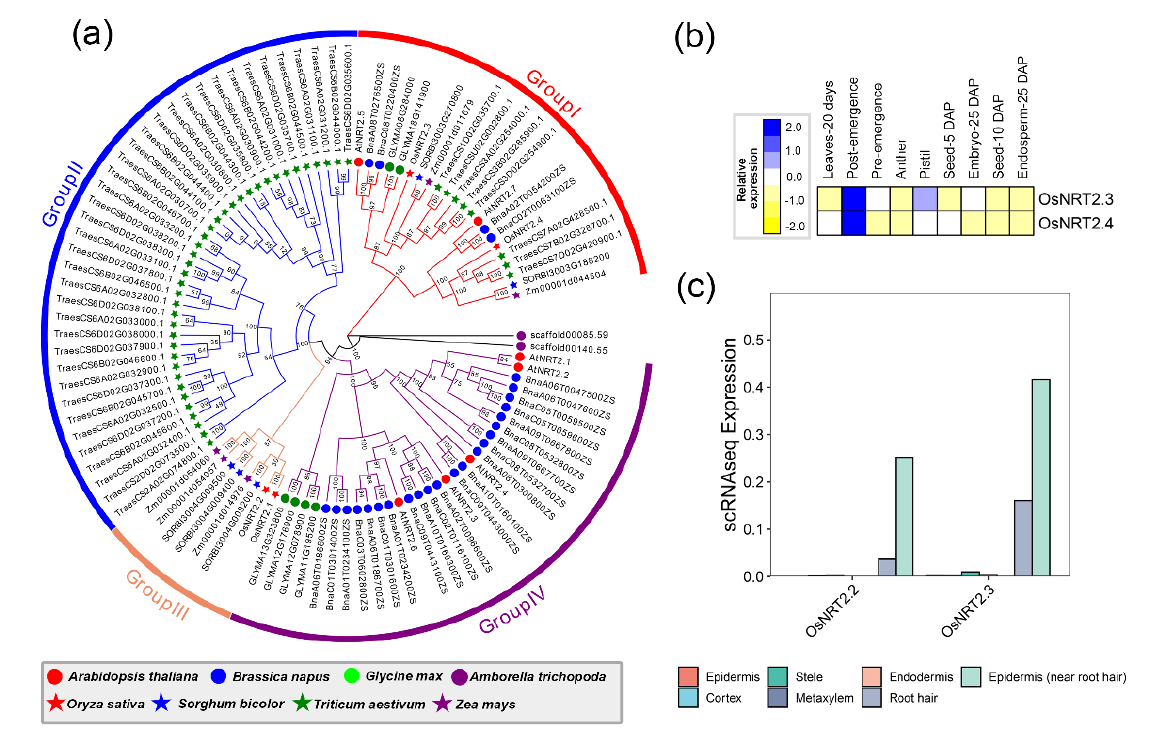
Figure 6. The phylogenetic analysis and expression pattern of the NRT2 superfamily. ( a ) represents the phylogenetic trees of the NRT2 superfamily, splitting into four groups. The different colors on the branches were defined as the same group. ( b ) indicates the expression heatmap of the NRT1 superfamily. OsNRT2.1 and OsNRT2.2 were filtered with lower expression, and ( c ) represents the expression of NRT2 superfamily through the single-cell transcriptome data of roots in rice.